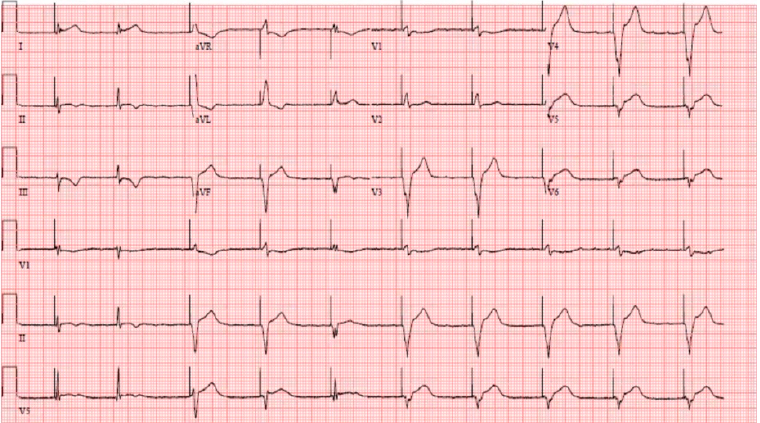
Figure 2. Electrocardiogram evidencing a ventricular-paced rhythm with occasional premature ventricular complexes.